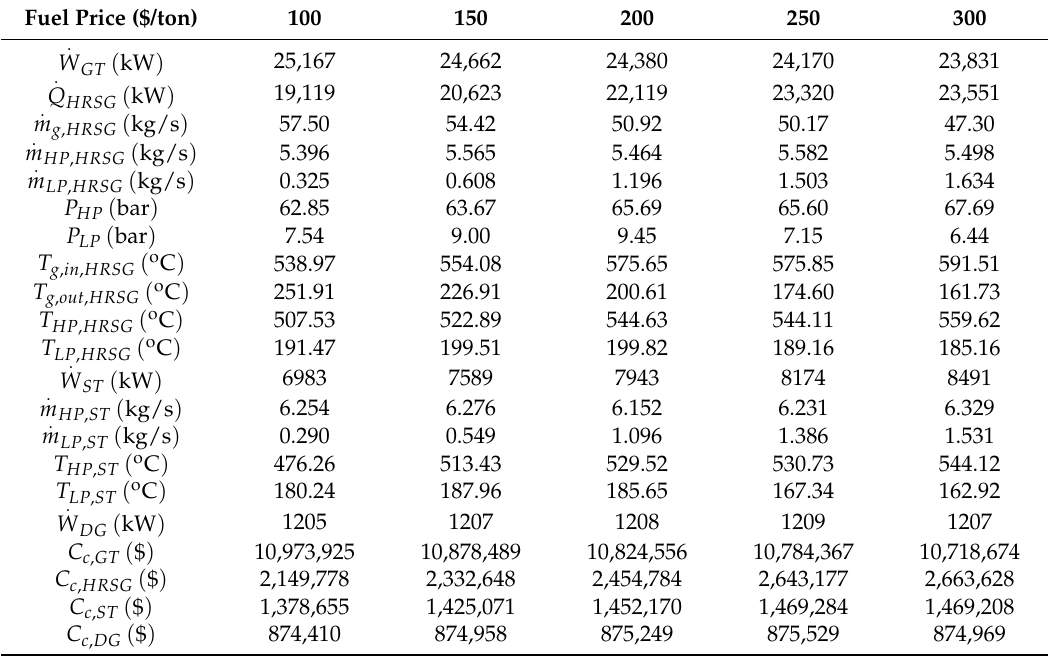
Table 15. Optimal design characteristics and capital cost of the system components for various prices of natural